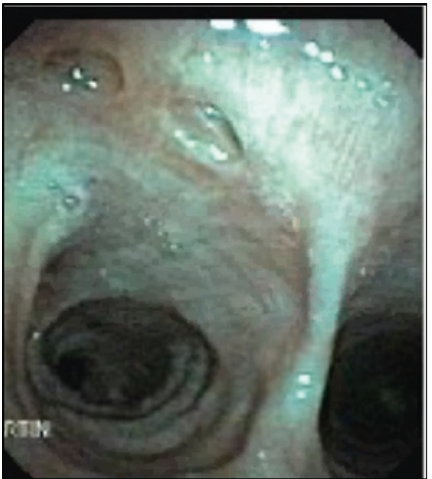
Figure 5: Bronchoscopy (posttreatment). There are two healed fistulas in the right posterior mainstem (posterior to carina), measuring approximately 0.5cm